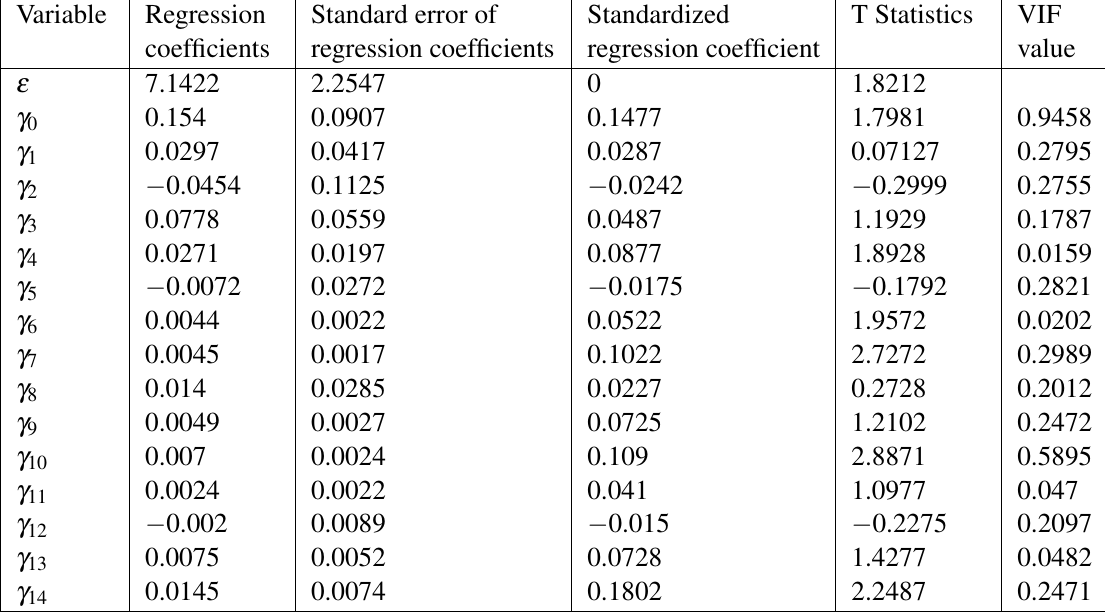
Fig. 4 Relationship between R2 and K value Table 1 Ridge regression estimation